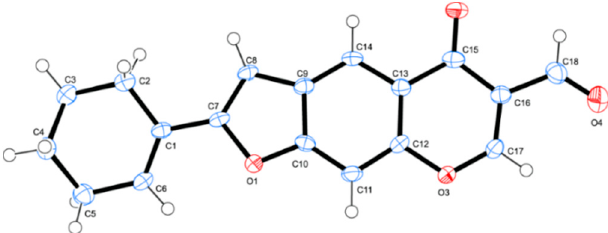
Figure 2. Oak ridge thermal ellipsoid plot (ORTEP) diagrams (50% probability level) of 2i . For clarity, hydrogen atoms are not labeled.